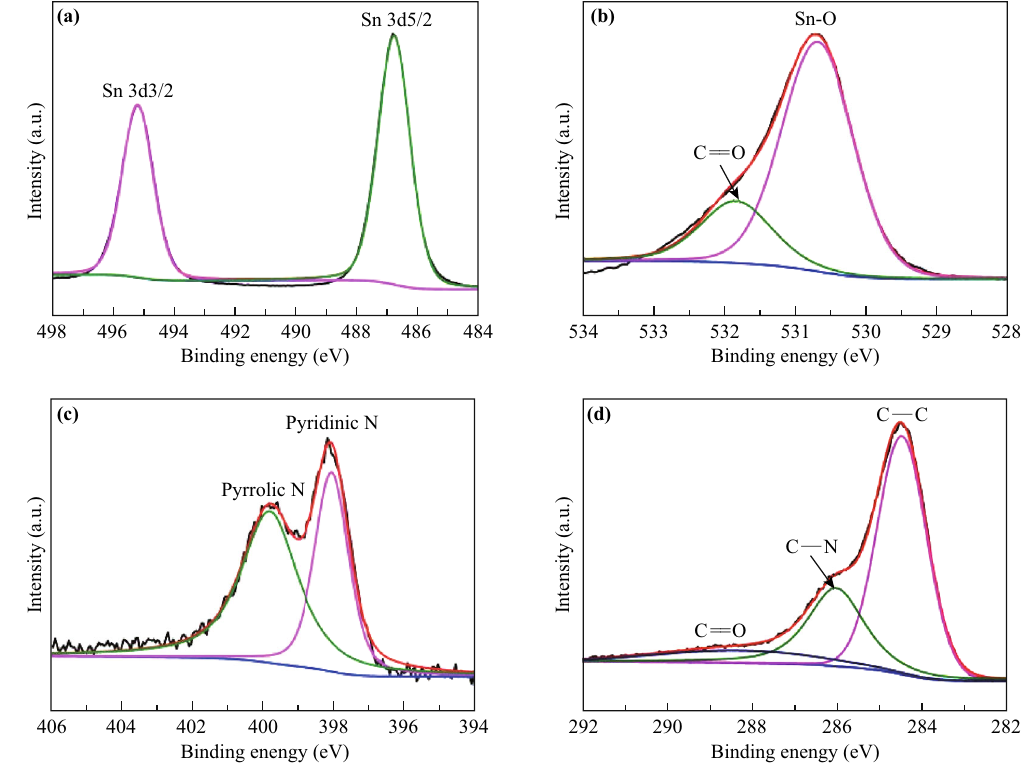
Fig. 4 XPS spectra of the NC@SnO 2 : a Sn 3d, b O 1s, c N 1s, and d C 1s. (Color figure